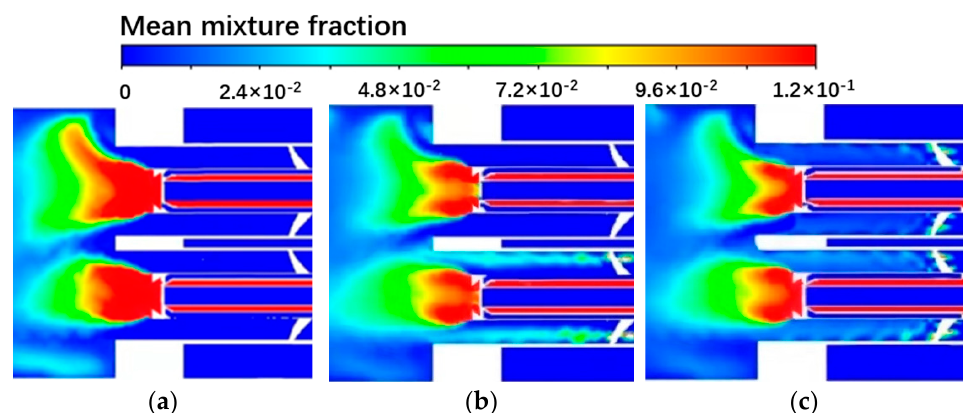
Figure 8. Calculation results of temperature distribution of each mode in startup stage. ( a ) Diffu- sion; ( b ) Sub-pilot premix; ( c ) Pilot premix.